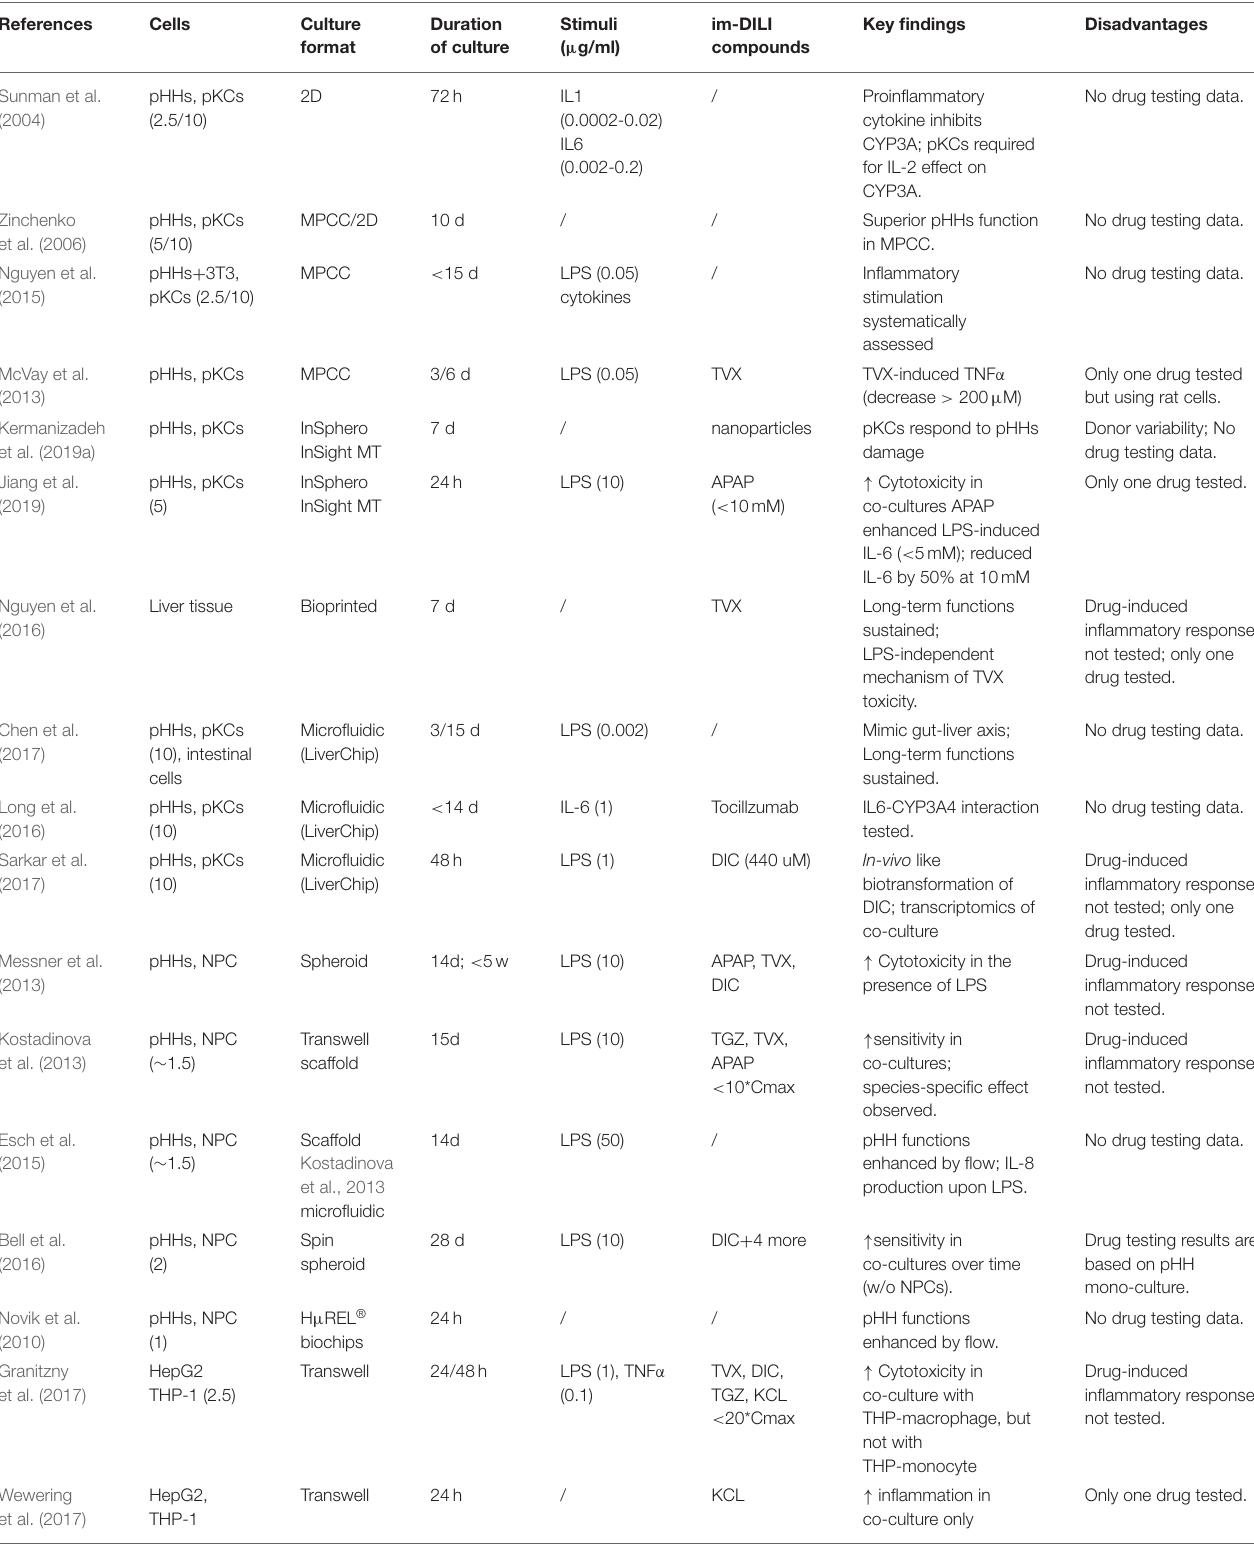
TABLE 3 | Human in vitro liver co-culture models comprising of hepatocytes and immune